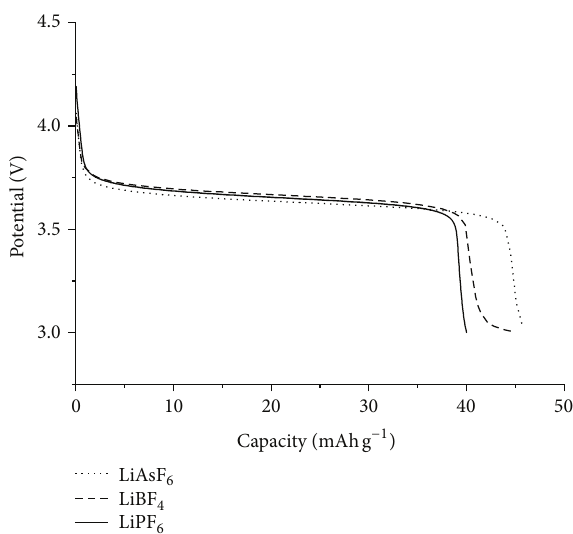
Figure 7: Cyclic voltammogram of the composite electrode with various scan rates.